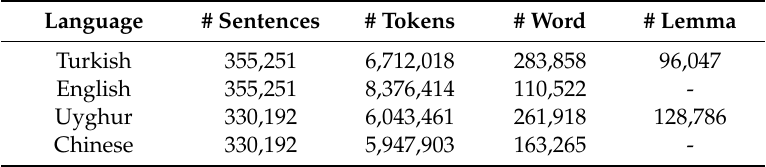
Table 1. The statistics of the training dataset for Turkish–English and Uyghur–Chinese translation.